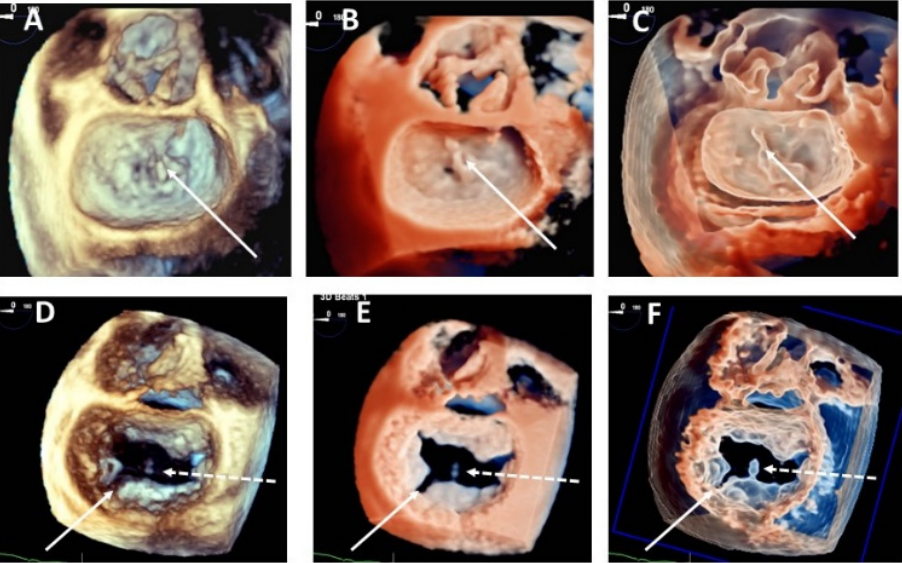
Figure 3. Head-to-head comparison among standard 3DTEE surgical view rendering (left panels), transillumination (central panels) and transparency (right panels) in 2 cases with chordal rupture and clefts. Upper panels: 3DTr ( B ) and 3DGl ( C ) rendering significantly improve chordal rupture visualization (arrows) in a flail P2. Lower panels: 3DTr ( E ) and 3DGl ( F ) rendering significantly improve cleft visualization between P2 and P1 (arrows) TGl allows a more precise delineation of a P2 flail and chordal rupture (dotted arrows).